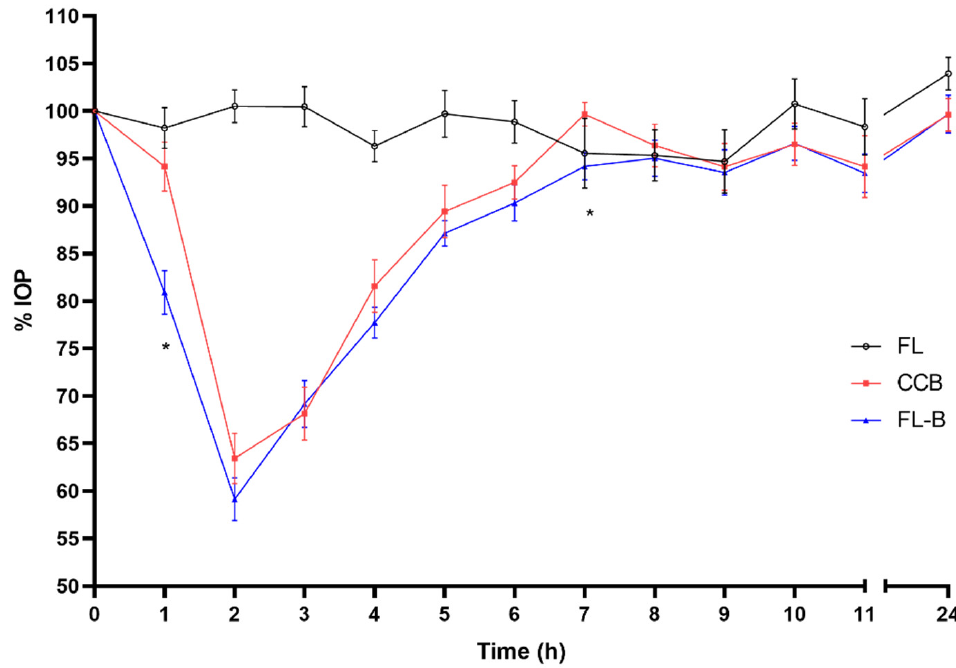
Figure 5. Decrease in intraocular pressure after administration of the liposomal formulation con- taining brimonidine (0–24 h), with statistical significance between CCB and FL-B formulations (* p < 0.05).